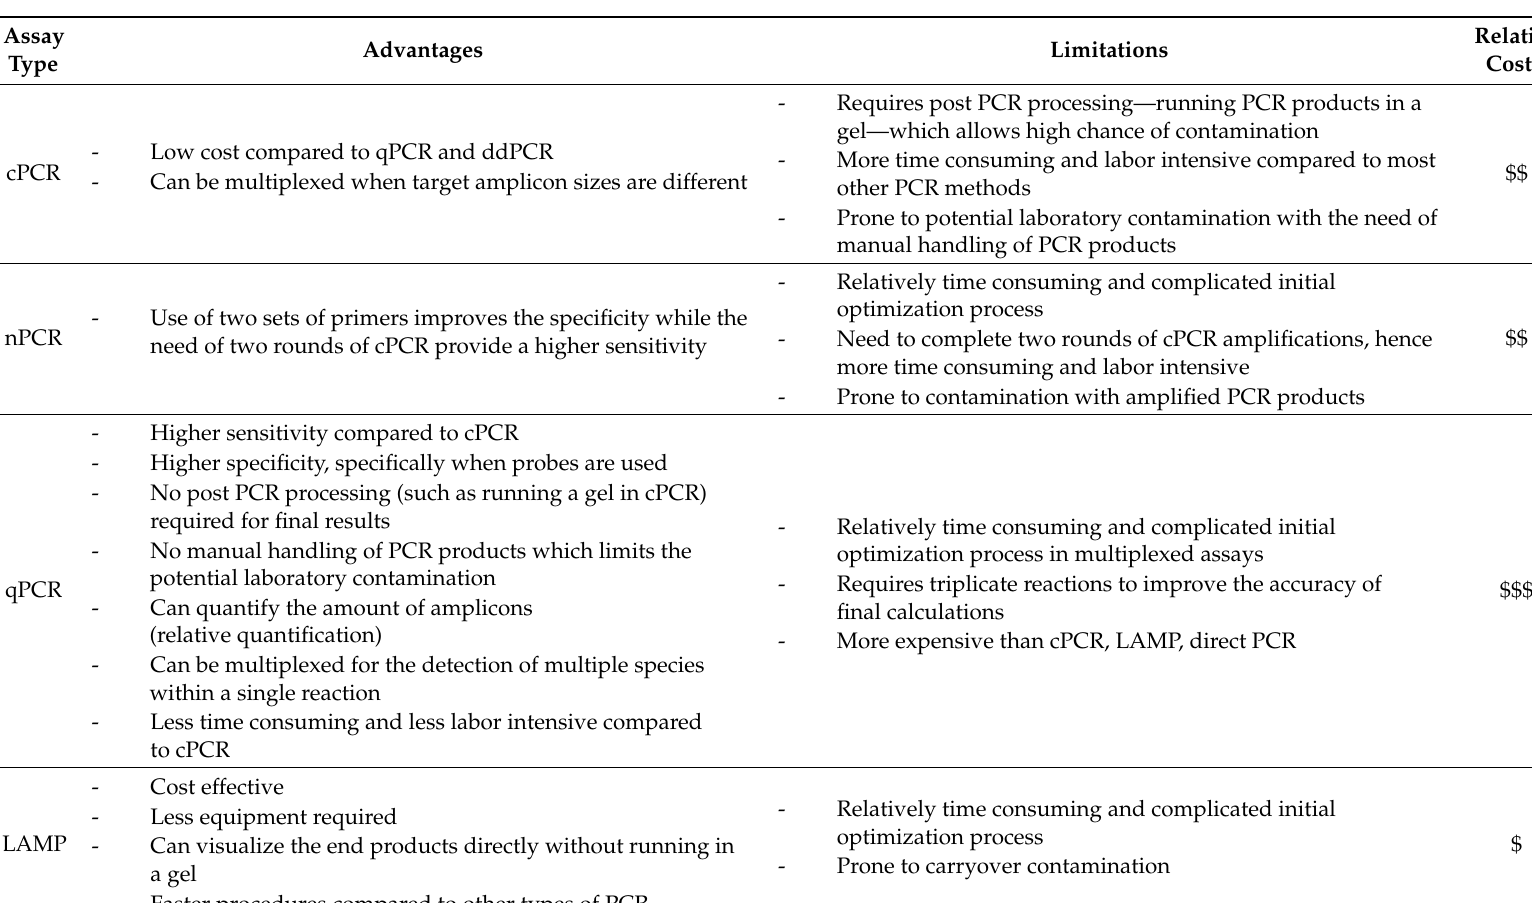
Table 1. Advantages and limitations of different DNA